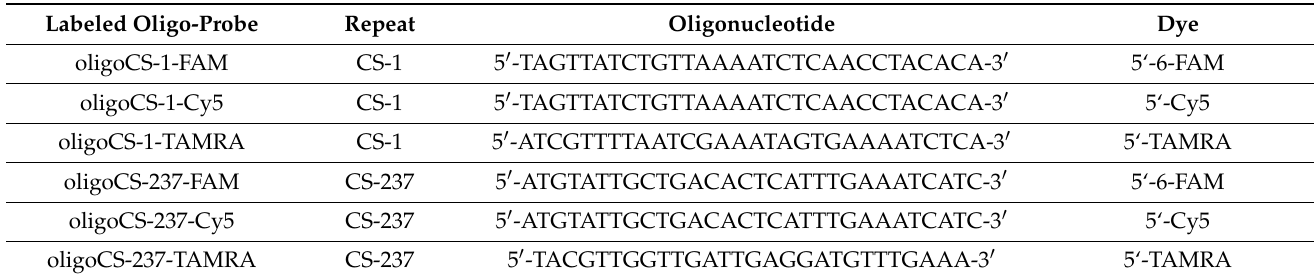
Table 1. Labeled oligo-probes designed for the repeats CS-1 and CS-237.